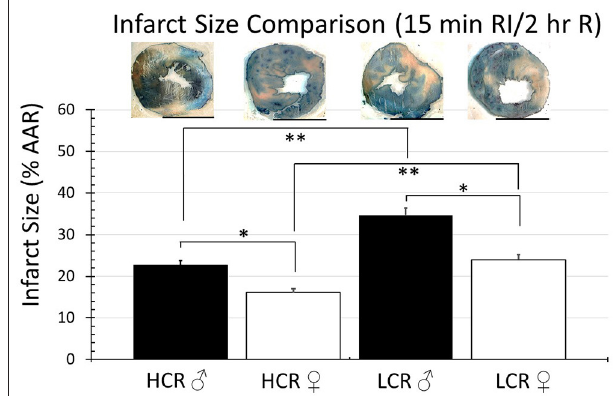
FIGURE 4 | Comparison of the average infarction size normalized to area at risk (%AAR) between HCR male/female and LCR male/female rats after 15min ischemia and 2h reperfusion using an in situ regional ischemia (RI) model. Infarct sizes were smaller for all groups compared to 30min regional ischemia ( Figure 2 ). Scale bars in images indicate 5mm. Significant differences were noted between sexes within each phenotype, and also between phenotypes for each sex, with LCRS having larger average infarctions compared to HCRs (* P < 0.05 for the comparison indicated between sexes within phenotype; ** P < 0.05 for the comparison indicated between phenotype within sex).